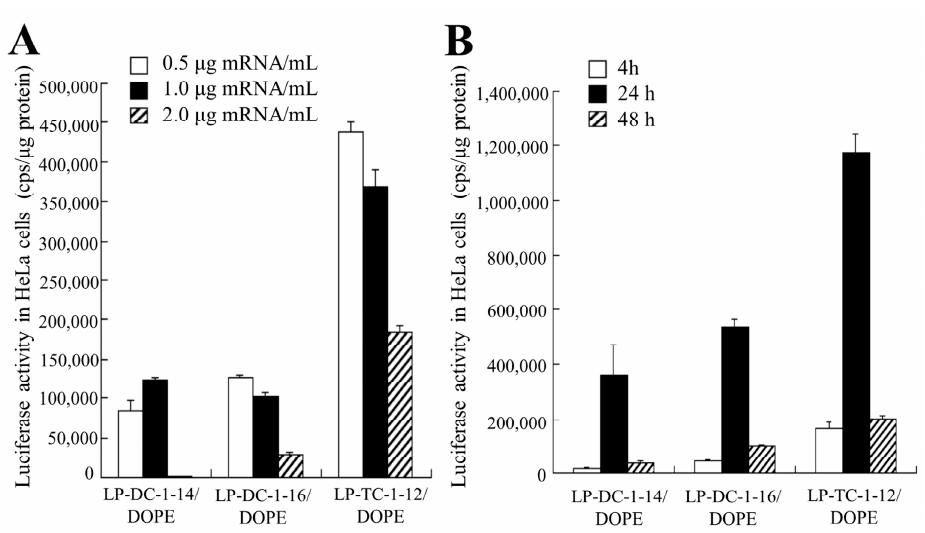
Figure 5. E ff ect of incubation time and mRNA concentration on luciferase expression in HeLa cells after transfection with FLuc mRNA lipoplexes. LP-DC-1-14/DOPE, LP-DC-1-16/DOPE, and LP-TC- 1-12/DOPE lipoplexes with FLuc mRNA were added to HeLa cells. ( A ) Luciferase activities were measured 24 h after transfection of mRNA lipoplexes at 0.5, 1, or 2 µg/mL mRNA. ( B ) Luciferase activities were measured 4, 24, or 48 h after transfection of mRNA lipoplexes with FLuc mRNA at 0.5 µg/mL mRNA. Each column represents the mean + S.D. ( n = 3).